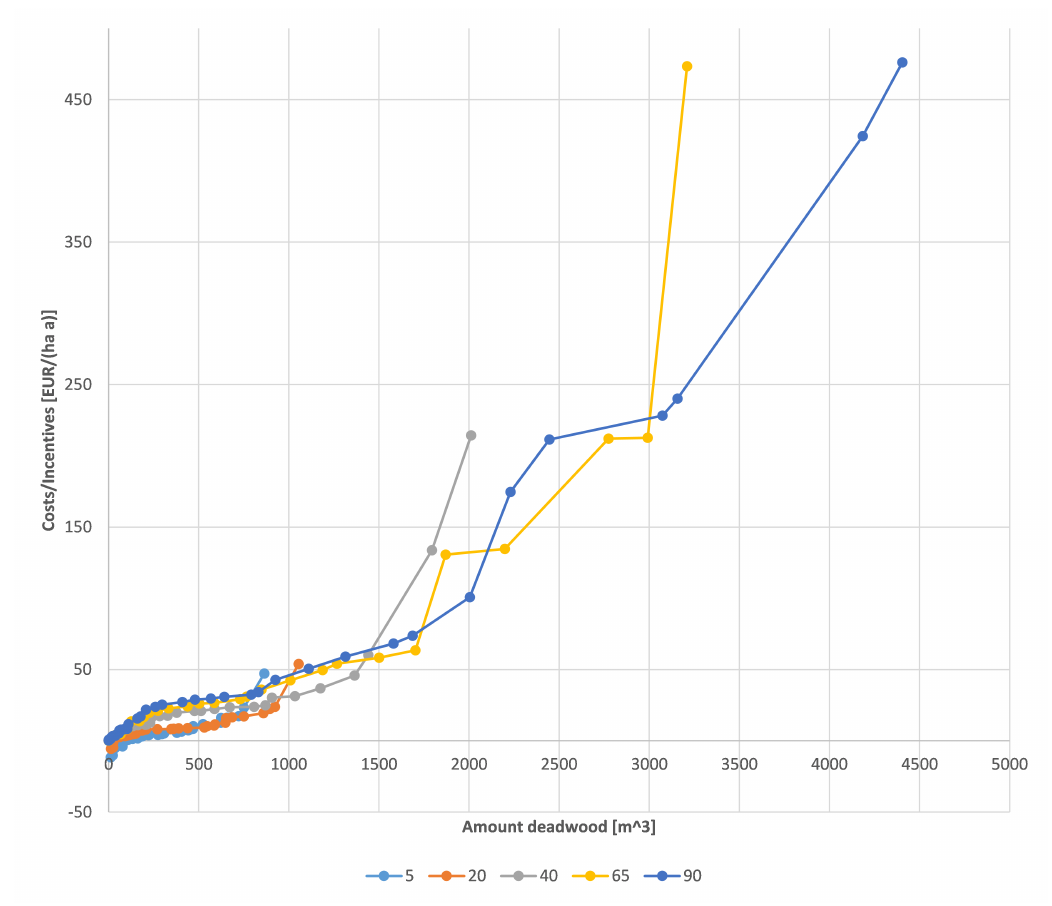
Figure 8. Forest enterprise “Eichelberg”: Costs or necessary compensations (incentives) in [ e ha − 1 a − 1 ] of absolute deadwood amounts in [m 3 ], to be maintained within 30 years, using total trees of beech. The different colours correspond to the average deadwood volume from 5m 3 ha − 1 to 90m 3 ha − 1